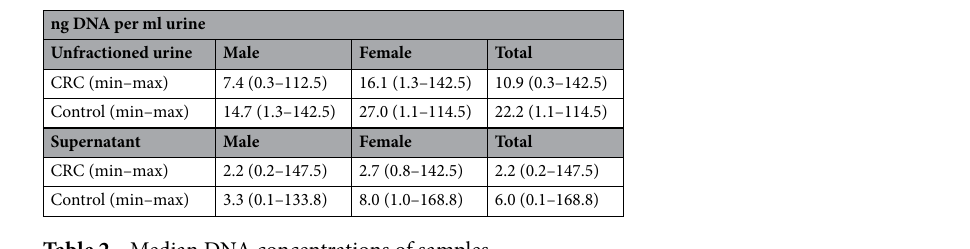
Table 2. Median DNA concentrations of